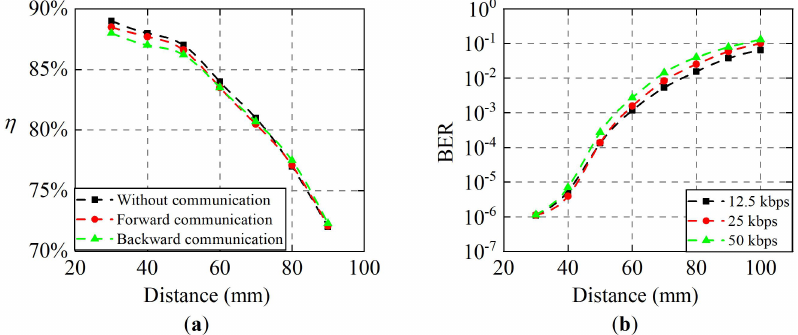
Figure 19. Power and information transmission under different coil distance. ( a ) System efficiency with and without communication. ( b ) Measured bit error rate (BER) under different data rates.